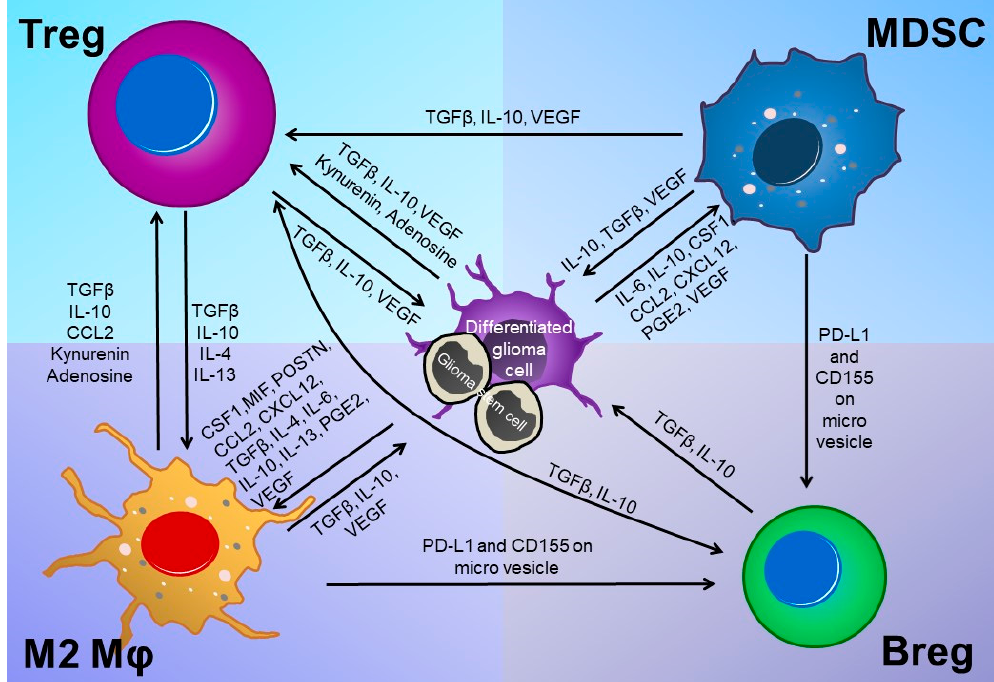
Figure 2. Complex crosstalk among tumor cells and various immune cells in glioma microenvironment. In the glioma microenvironment, the immunosuppressive environment is reinforced by a complex crosstalk between tumor cells and immunosuppressive cells and between different immunosuppressive cells.